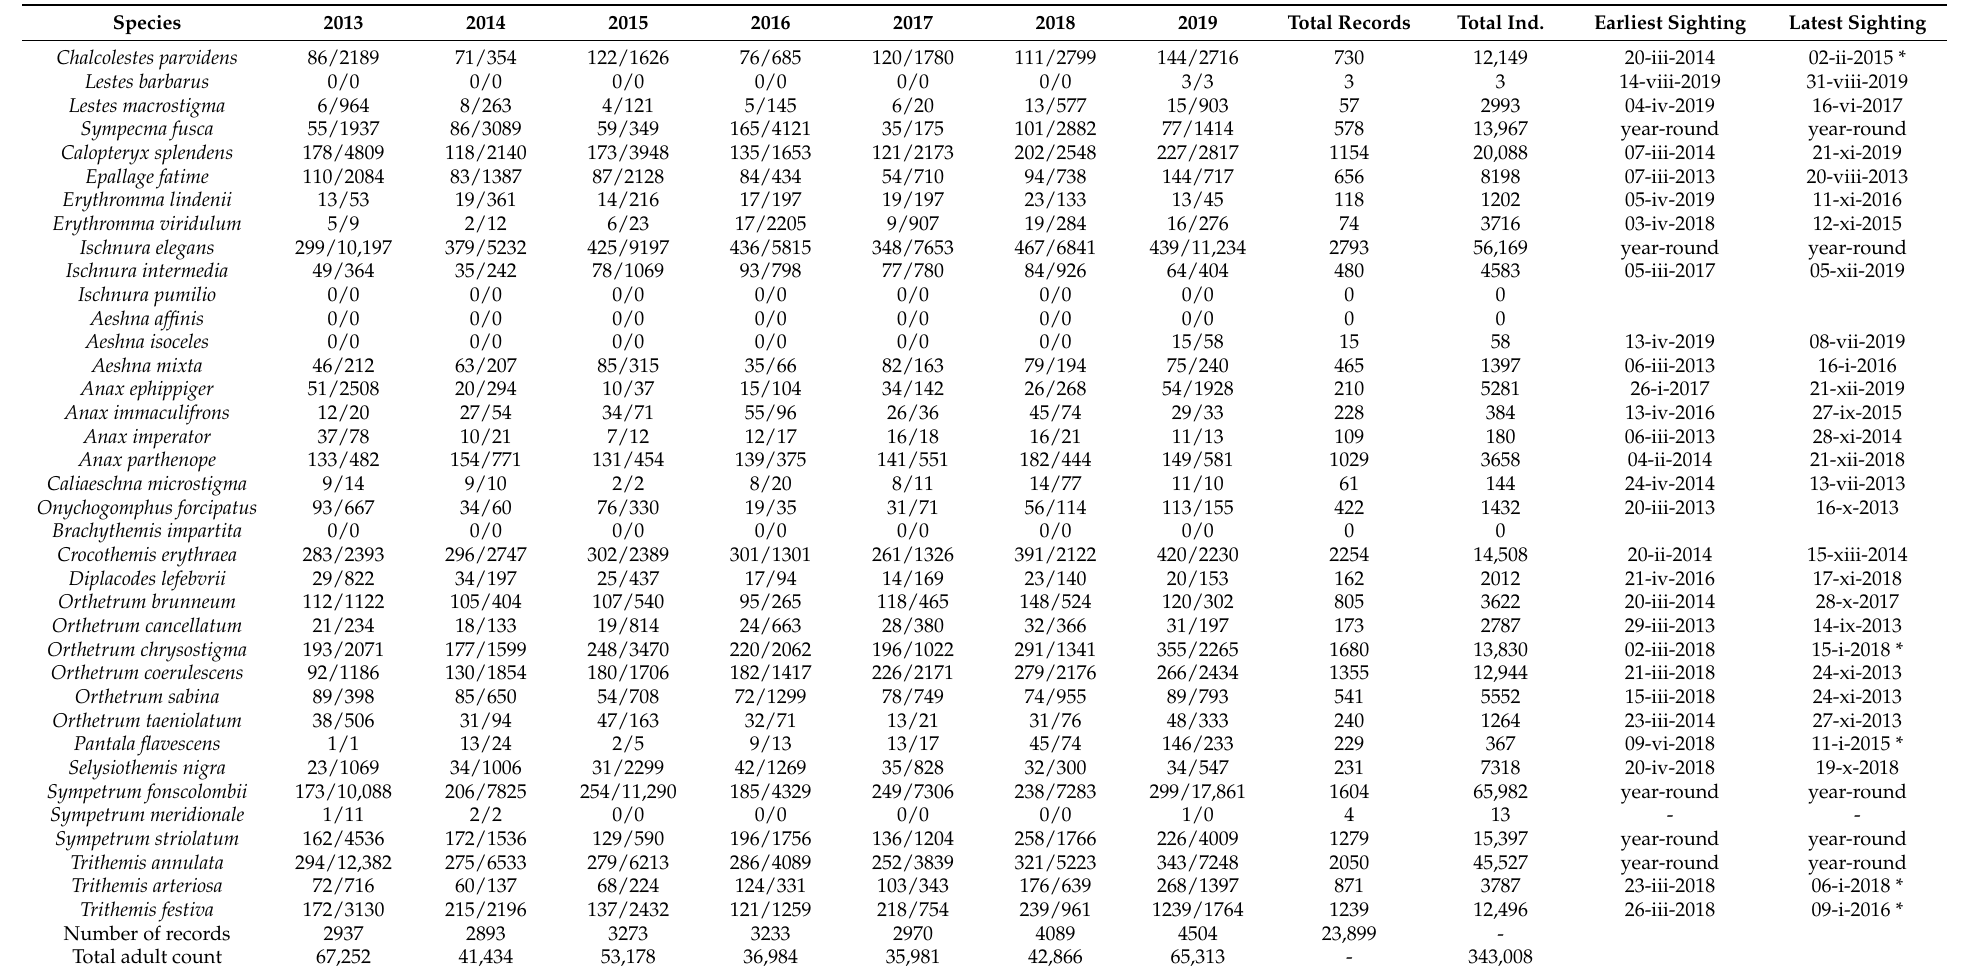
Table A1. Number of records and adult counts (records/counts of adults) of dragonflies and damselflies on Cyprus and earliest and latest annual sighting for each species stored in the CDSG database for the period 2013 to 2019. * Species for which the flight season extends into the early months of the following